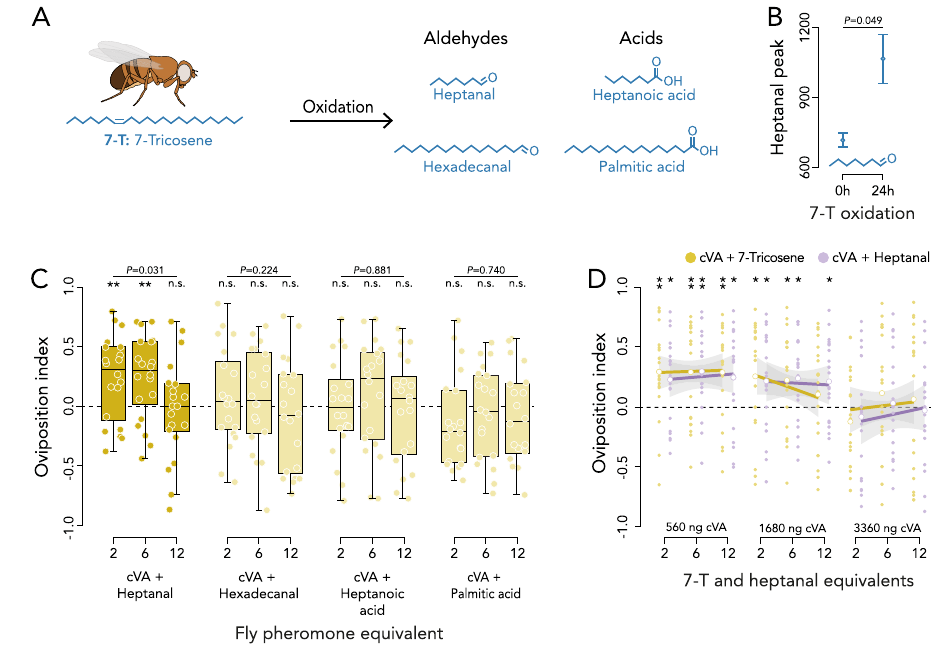
Fig. 3 | The oxidation of 7-Tricosene and its effect on the detection of ovipo- sitionsites.A 7-Tricoseneispredictedtoautoxidizeintoheptanalandhexadecanal (both saturated aldehydes), heptanoic acid (an aliphatic carboxylic acid) and pal- mitic acid (a saturated long-chain fatty acid). B Mean area under the peak for heptanaldirectly(i.e.0h)and24hafterexposing7-Ttoambientoxygen.Statistical outcome as analyzed with a Kruskal – Wallis test. Error bars indicate standard error of the mean( n =3pertime point). C Oviposition preferencetocVAcombined with heptanal (100 – 300 – 600ng), hexadecanal (210 – 630 – 1260ng), heptanoic acid (115 – 345 – 690ng) and palmitic acid (220 – 660 – 1320ng; Fig. S1E – F for additional 100 – 300 – 600ng). The linear analysis ( fi tted with GLM) is visualized with its 95% con fi dence intervals (gray shaded area). The individual replicates are visualized by